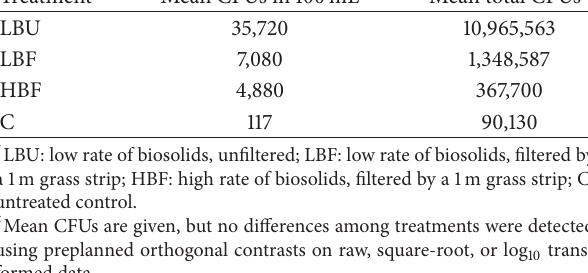
Table 3: Concentration and total fecal coliform colony-forming units (CFUs) in